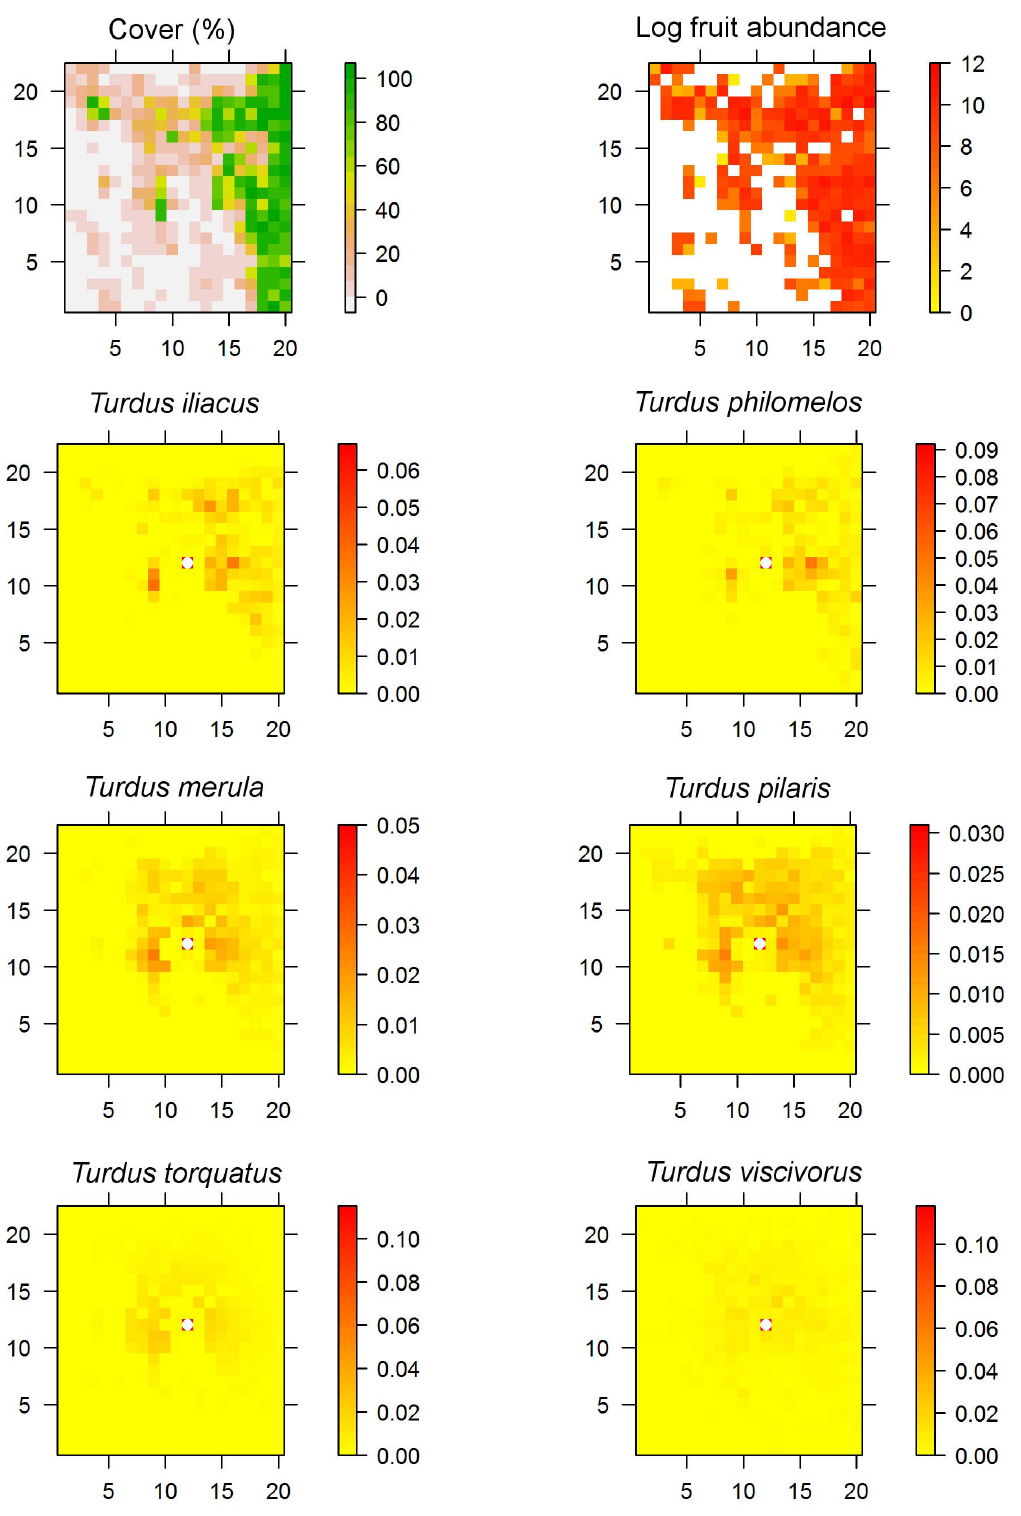
Figure 4. Cover, fruit abundance and maps of simulated seed rain from a central landscape cell (marked with a white dot) by each bird species. Seed rain is mapped as proportion of the total number of seeds dispersed. doi:10.1371/journal.pone.0065216.g004 variables, forest cover (arcsin sqrt proportion) and fruit abundance (log number of fruits per cell). We run similar models for both the